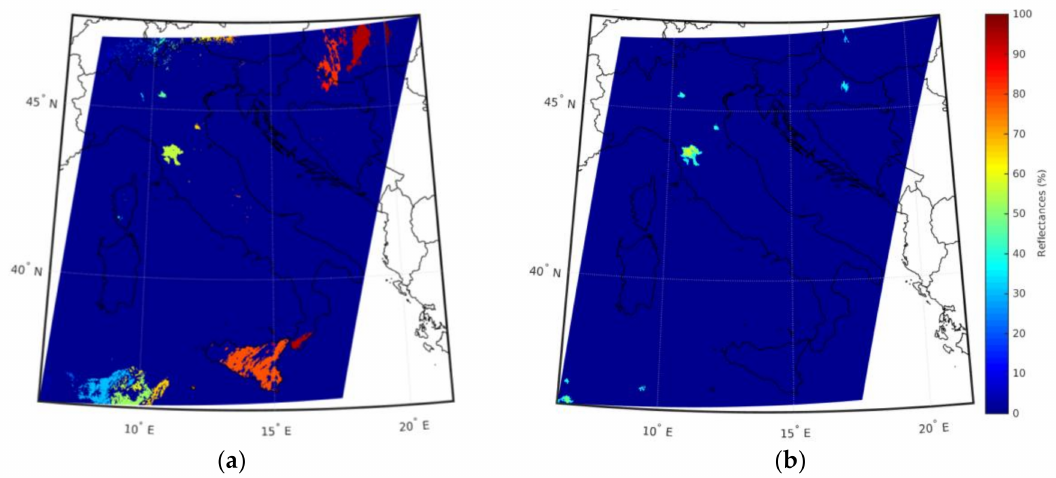
Figure 6. ( a ) MSG_SEVIRI SatFog Cloud Entities product. Each detected entity has been represented with a different colour. ( b ) MSG-SEVIRI SatFog final product in which are reported the HRV reflectances of the entities identified as fog by the algorithm